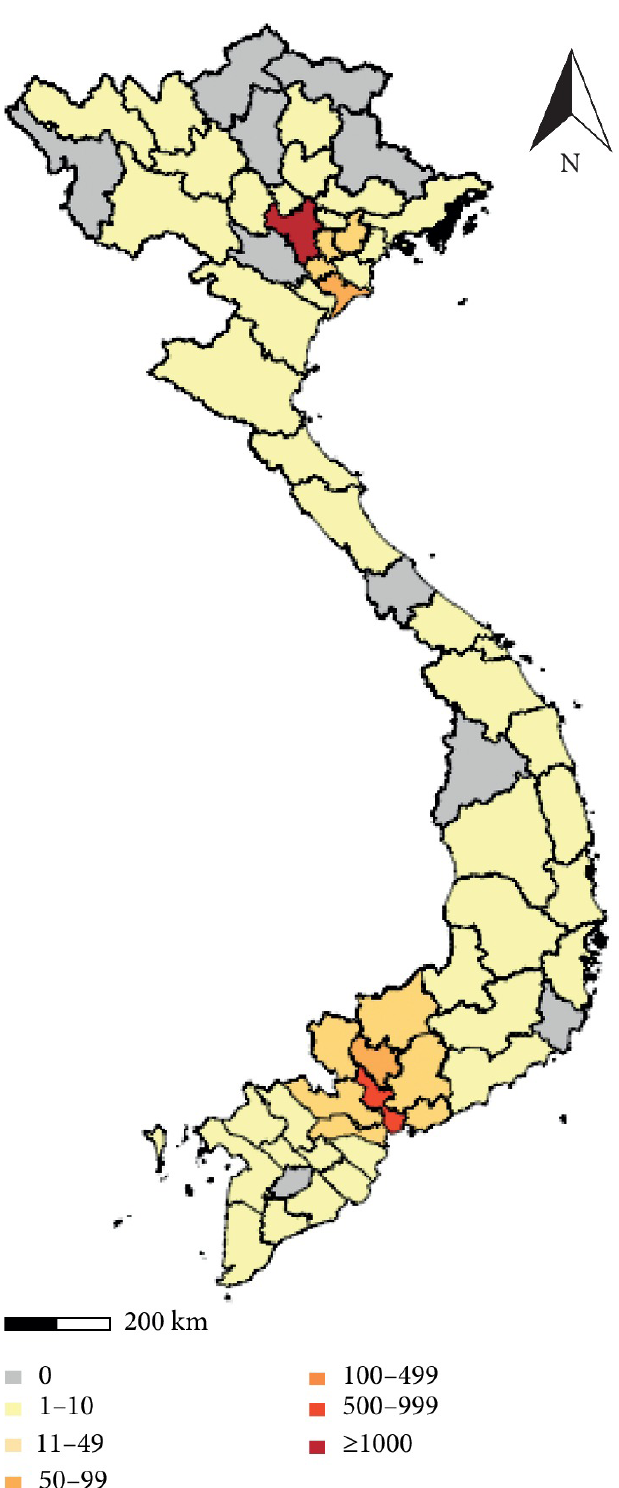
FIGURE 1 - ŁMap of areas affected by the dengue epidemic of Vietnam in 2017 (Huy et al.,